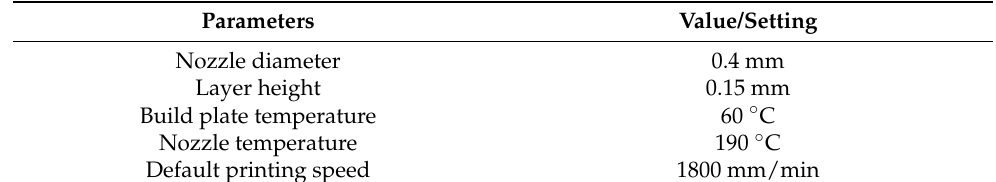
Table 2. Key parameters in the additive manufacturing process.